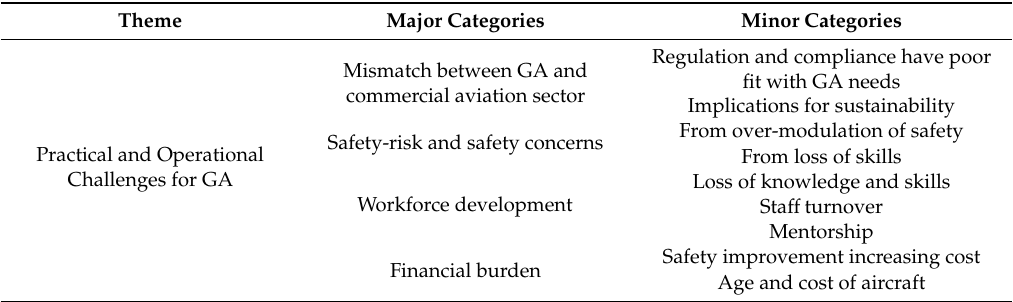
Table 7. Summary of findings for Practical and Operational Challenges for the GA